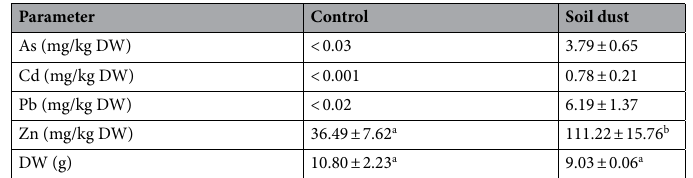
Table 2. Contents of risk elements and leaf yields in the control and soil dust treatments. DW represents the dry weight per treatment. Values are means ± SD ( n = 4). Lower-case letters indicate significant differences based on Fisher’s LSD test ( p ≤ 0.05). Data with the same letter are not significantly different.